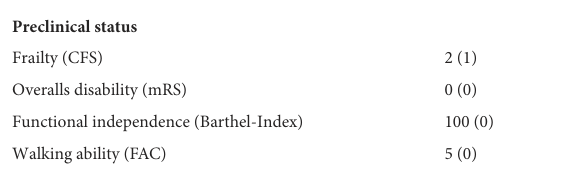
TABLE 2 Characteristics of included